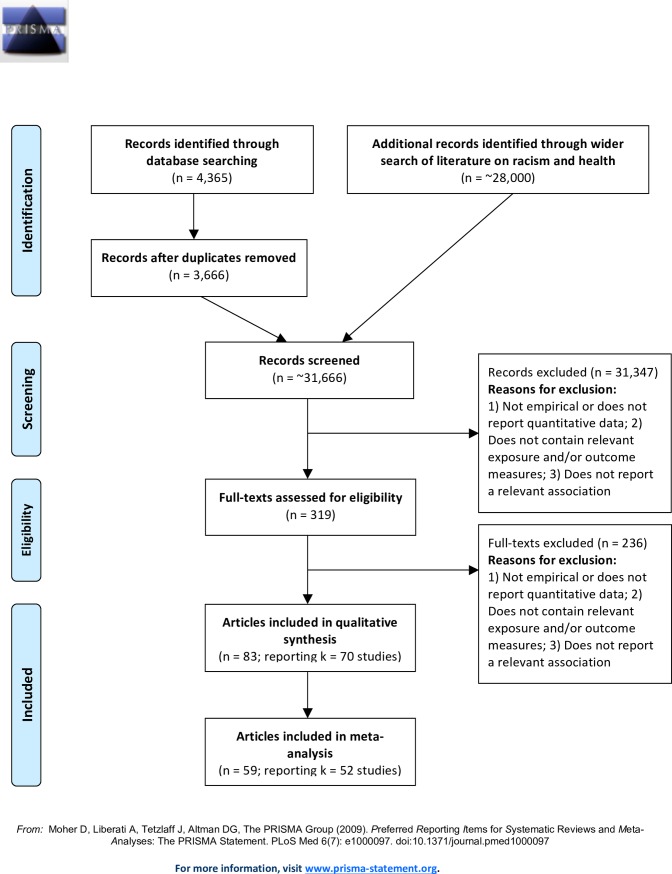
PRISMA flow diagram.